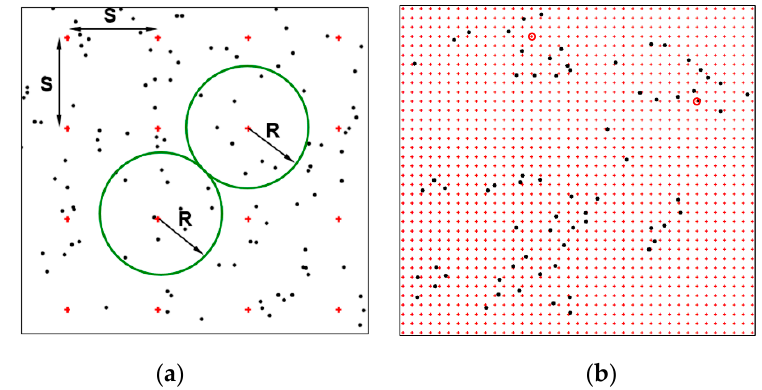
Figure 2. The procedure of creating a GRID structure: ( a ) determination of node values based on measurement points (S—distance between nodes, R—search radius); ( b ) interpolation grid generated based on the measurement points for 2012 (the analyzed nodes are marked with a circle). Source: own elaboration.